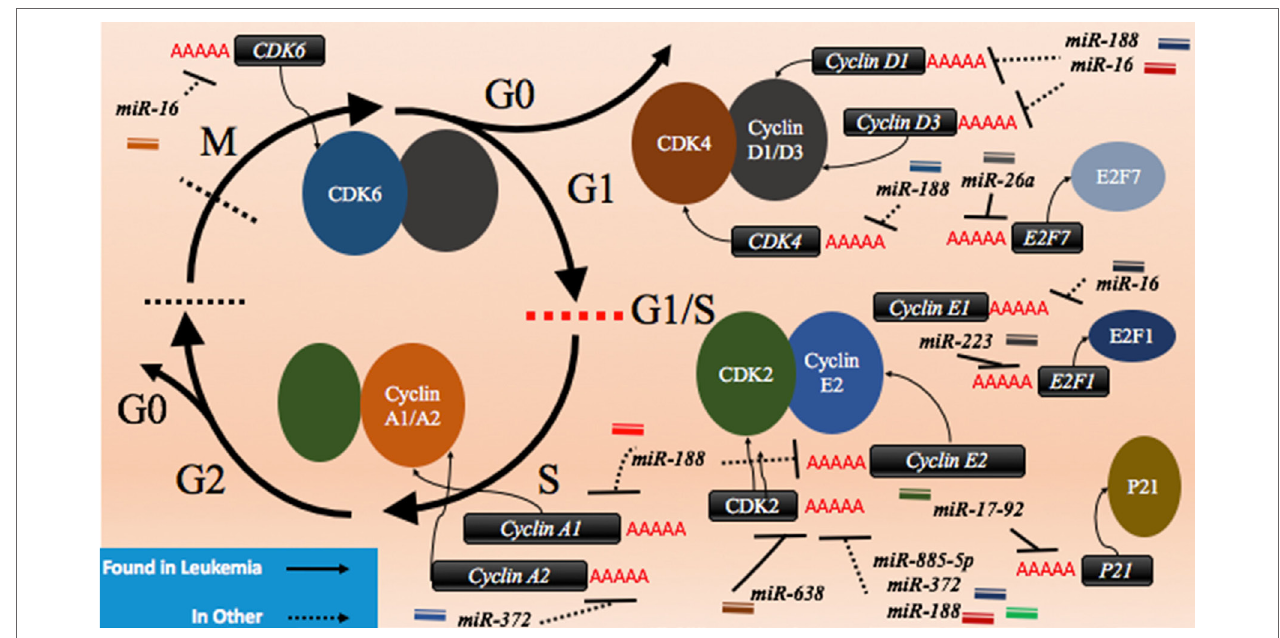
FigURe 3 | microRNAs (miRNAs) can dysregulate cell cycling mechanisms by dysregulating several phases of the cell cycle, but the majority of known targeting occurs at the G1 and S phases and at the G1/S transition. The downregulation of the cyclins that would normally signal for cell cycling to proceed can be downregulated. Cyclin D1 and cyclin D3 can be dysregulated by miR-188 and miR-16, cyclin E1 can be knocked down by miR-16 while cyclin E2 can be downregulated by miR-17-92 and finally, cyclin A1 and A2 are downregulated by miR-188 and miR-372, respectively. The cyclin-dependent kinases (CDKs) are also adjustable through miRNA targeting and their targeting reduces cycling as well. CDK2 can be downregulated by miR-638, miR-885-5p, miR-372, and miR-188; CDK4 is downregulated by miR-188, and CDK6 is downregulated by miR-16. Effector proteins such as E2F1, E2F7, and p21 can also be downregulated by miRNAs to lead to differentiation blocks. They can be targeted by miR-223, miR-26a, and miR-17-92,